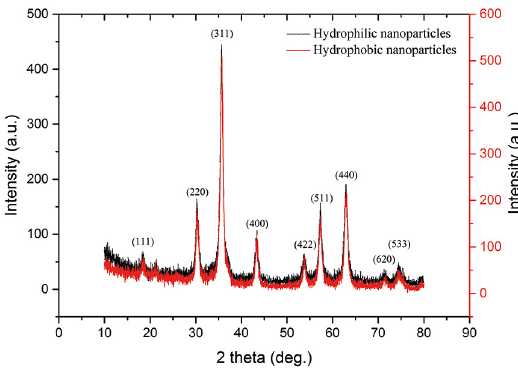
Figure 3. X-ray diffractograms of the magnetic nanoparticles.